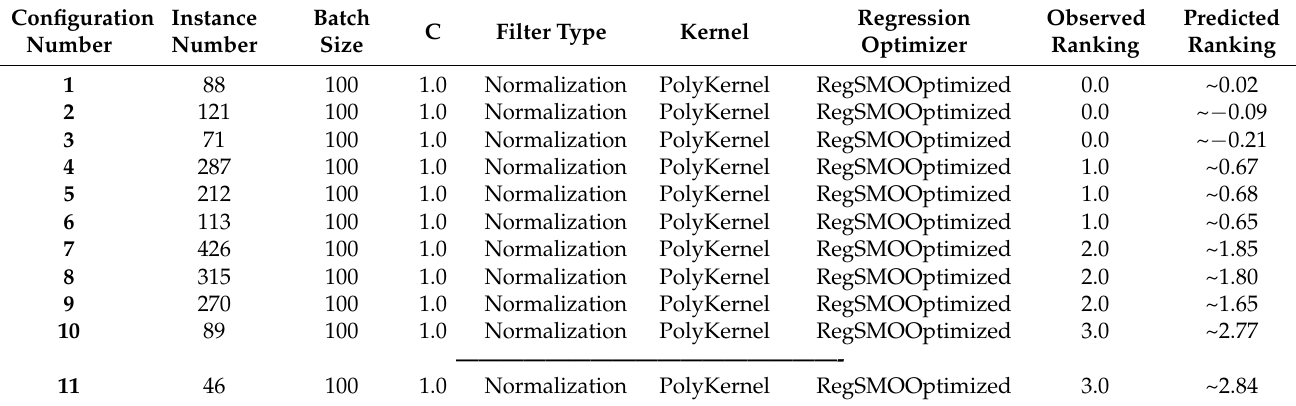
Table 6. Comparison of the Configuration Results.